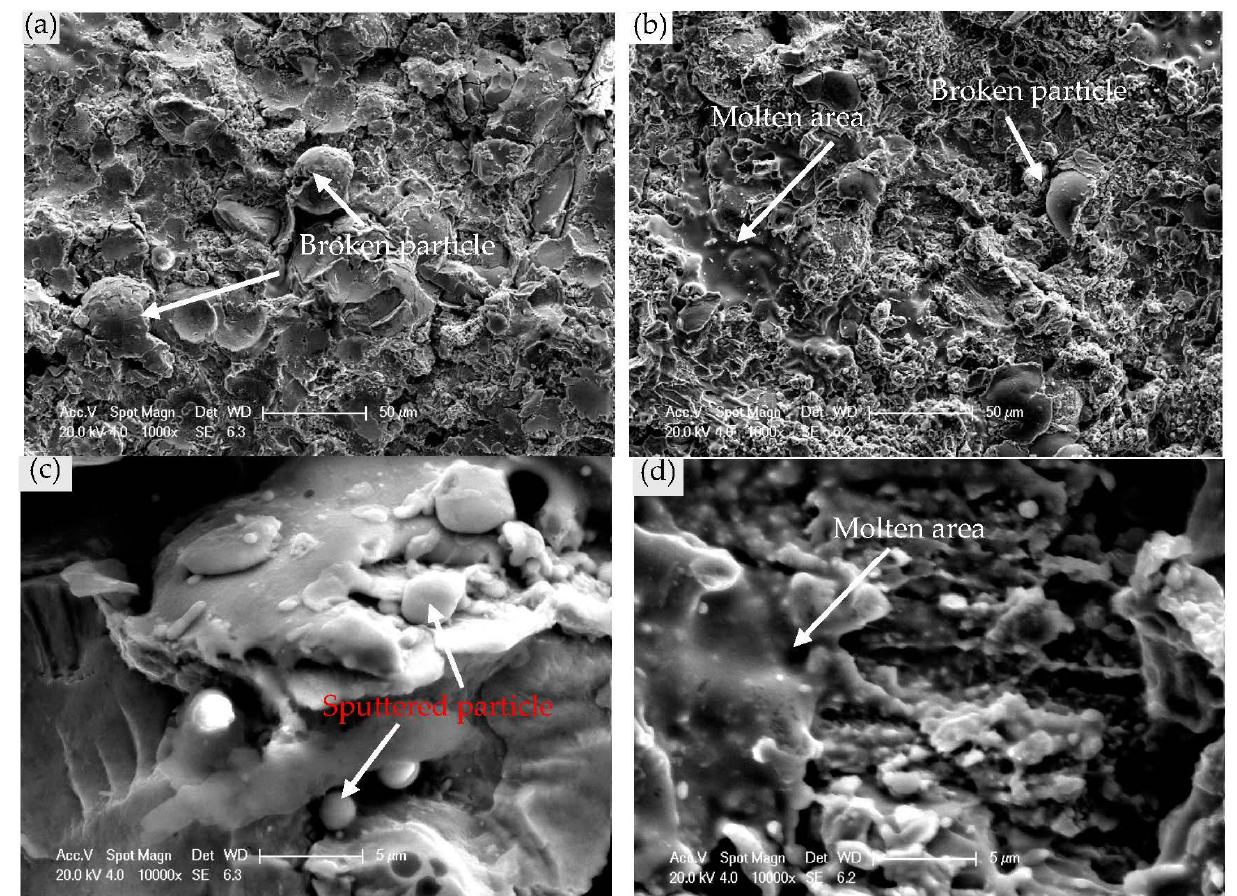
Figure 3. ( a , c ) are the morphology and high magnification picture of the as-sprayed Stellite 20